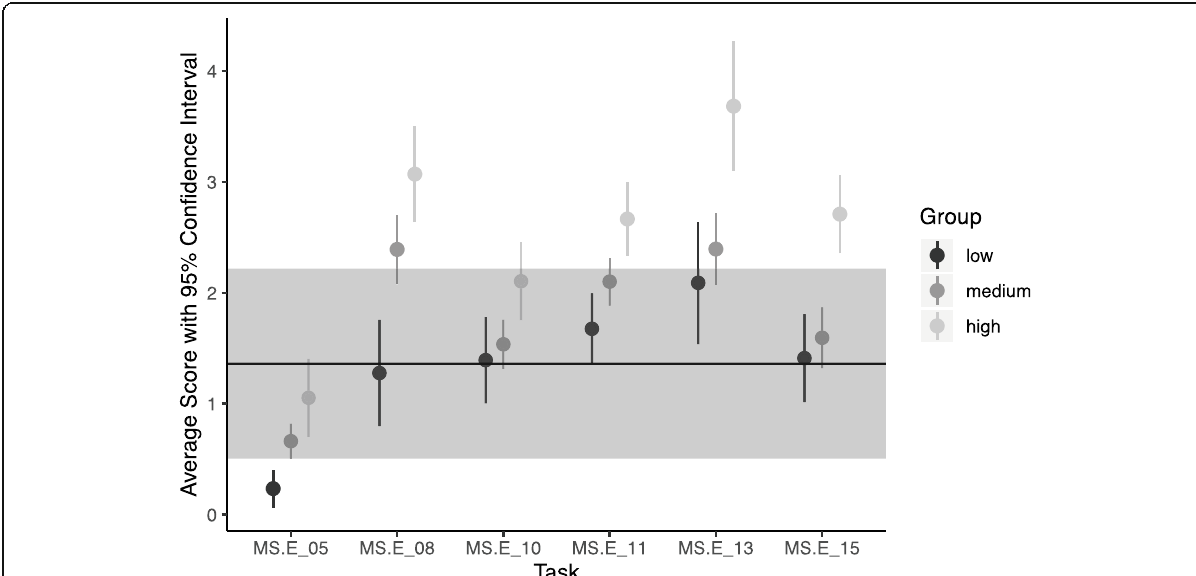
Fig. 6 Average score of low, medium, and high-achieving students on the post-test. Horizontal line and grey box represent average scores of low-achieving students in non-fields tasks and 95% confidence interval. MS.E_08 is the only task that required fields